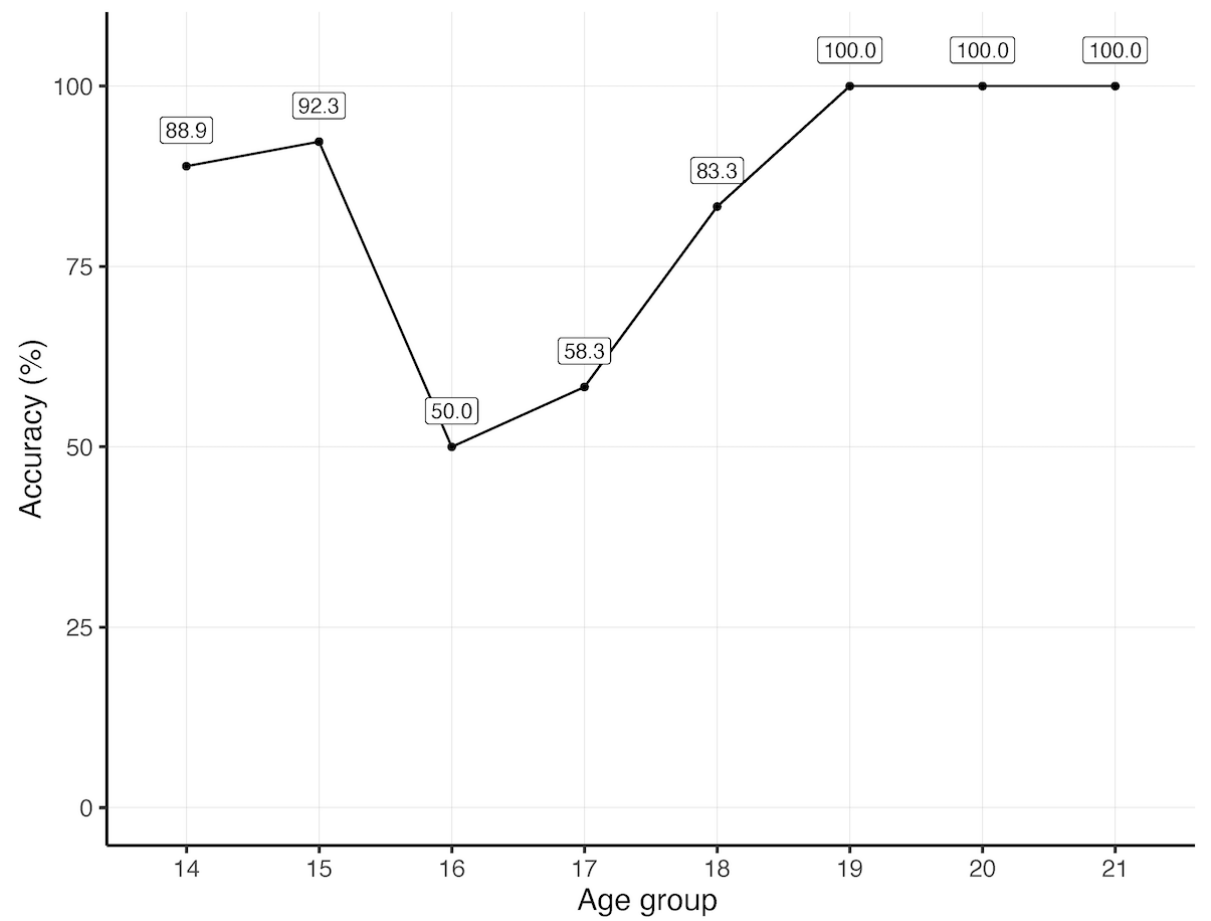
Figure 2. Accuracy per age group for the minor versus adults classification model, for female